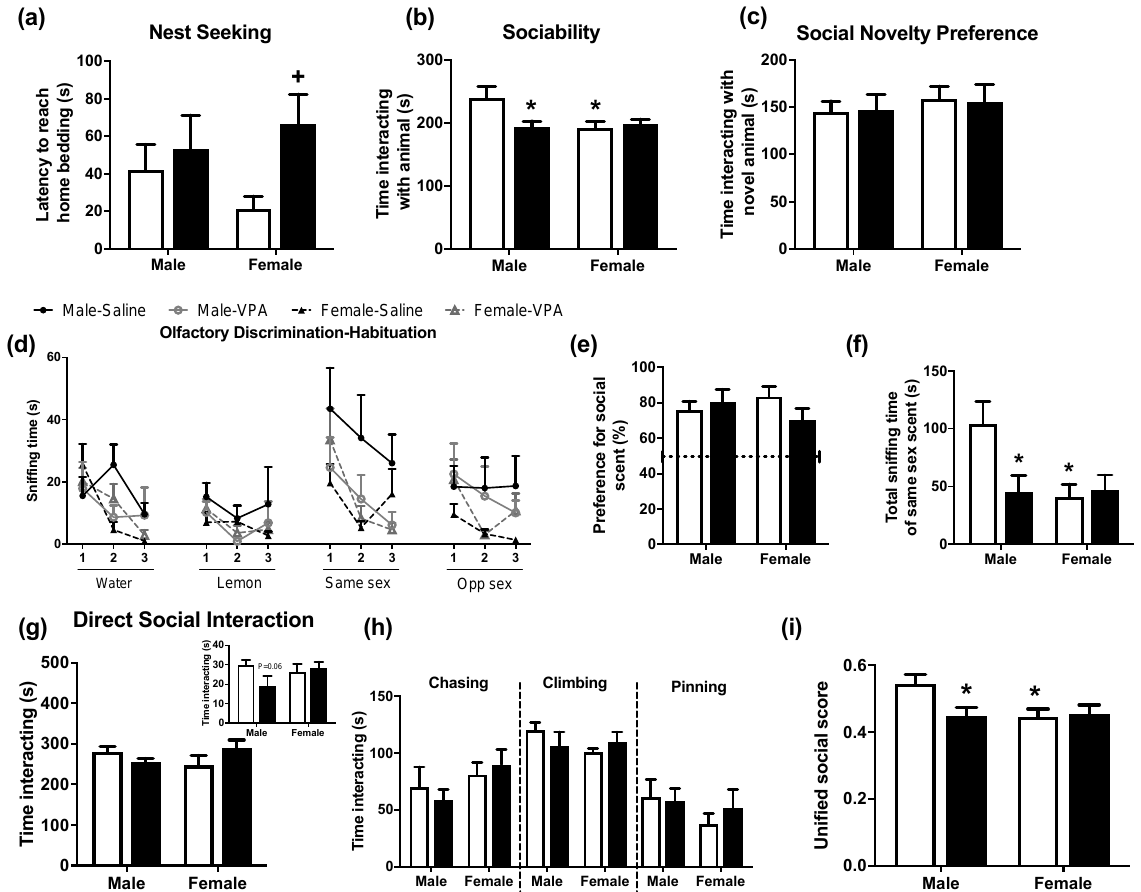
Figure 1. The effect of prenatal VPA exposure on social behaviour in male and female rats. ( a ) Latency to reach home bedding in the nest-seeking test at PND 13 (n = 7 to 10 per group). ( b ) Time interacting with animal in the sociability phase of the three-chamber test during adolescence (n = 10 to 11 per group). ( c ) Time interacting with novel animal in the social novelty preference phase of the three-chamber test during adolescence (n = 12 per group). ( d ) Time spent sniffing each scent (water, lemon, same sex, opposite sex), ( e ) discrimination index ((same sex)/(same sex + lemon) × 100) and ( f ) total time spent sniffing the same sex scent in the OHD test during adolescence (n = 7 to 12 per group). ( g ) Total social interaction during the 10 min DSI test and the first min of the trial and ( h ) chasing, climbing and pinning behaviour during the DSI test during adolescence (n = 6 per group). ( i ) Unified behavioural social score (n = 12 per group). Data expressed as mean + SEM. * p < 0.05 vs. saline-exposed males; + p < 0.05 vs. saline-exposed females.